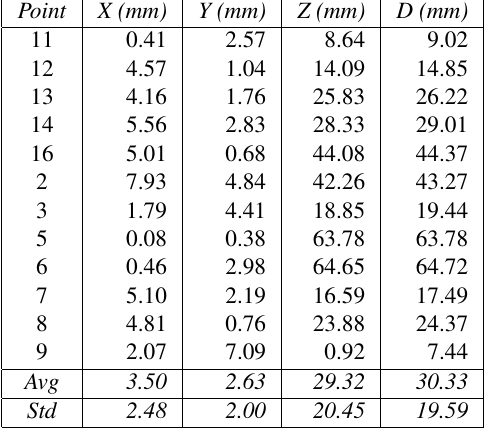
Table 3. Residual of CPs in detail of Case 2-Method